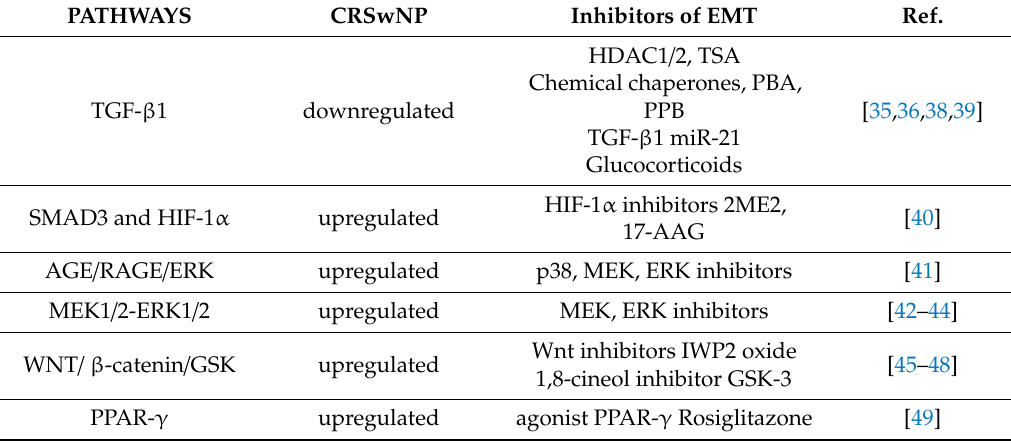
Table 1. Main signaling pathways involved in controlling the initiation and progression of epithelial to mesenchymal transition (EMT) during neural polypogenesis. The formation of the nasal polyp is supported by a marked tissue remodeling process induced by various inflammatory mediators and modulation of intra-cellular signaling pathways. The resulting EMT can be inhibited by signal transduction inhibitors, leading to the loss of epithelial gene expression and the simultaneous acquisition of the molecular component properties typical of mesenchymal